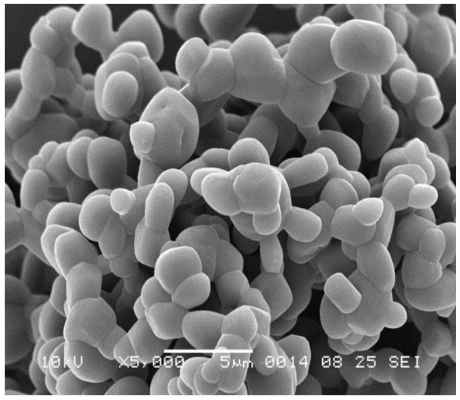
Figure 3. Representative scanning electron microscope (SEM) image of milled isoniazid without excipients. B2 batch. Magnification: 5000 × .